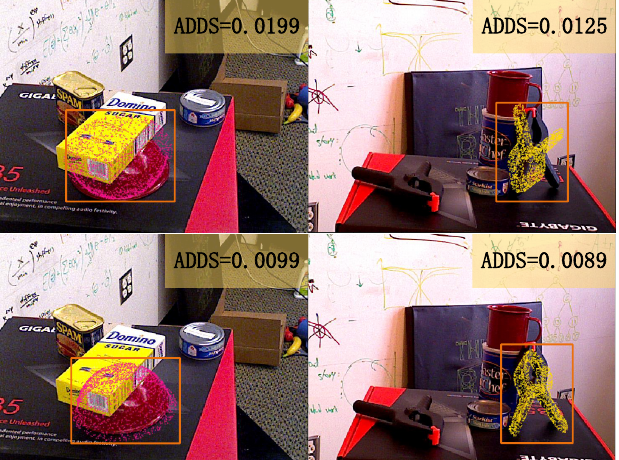
Figure 5. The particularly difficult Cases of Symmetric Objects. The first row are bad cases trained by ADD-S loss. The second row are examples of our model. The bowl and the clamp in the first row are found to be flipped. However, the ADD-S is small (<2 cm) for these bad cases. Here, the measuring unit we use is m. In addition, the 2 cm metric is utilized in